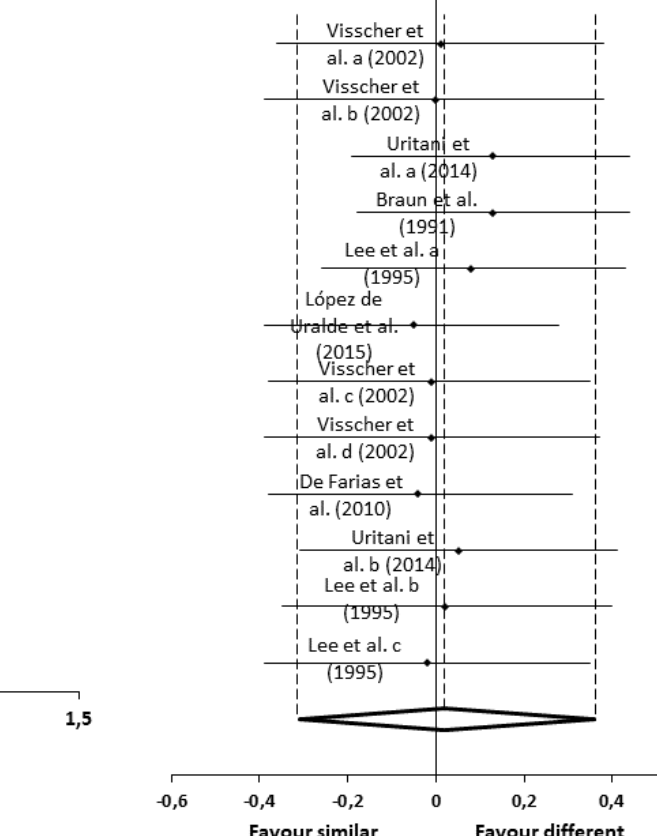
Figure A3. Publication bias heterogeneity funnel plot for the cervical spine alignment. A funnel plot was used to assess the risk of publication bias. The diagonal lines represent 95% confidence limits.